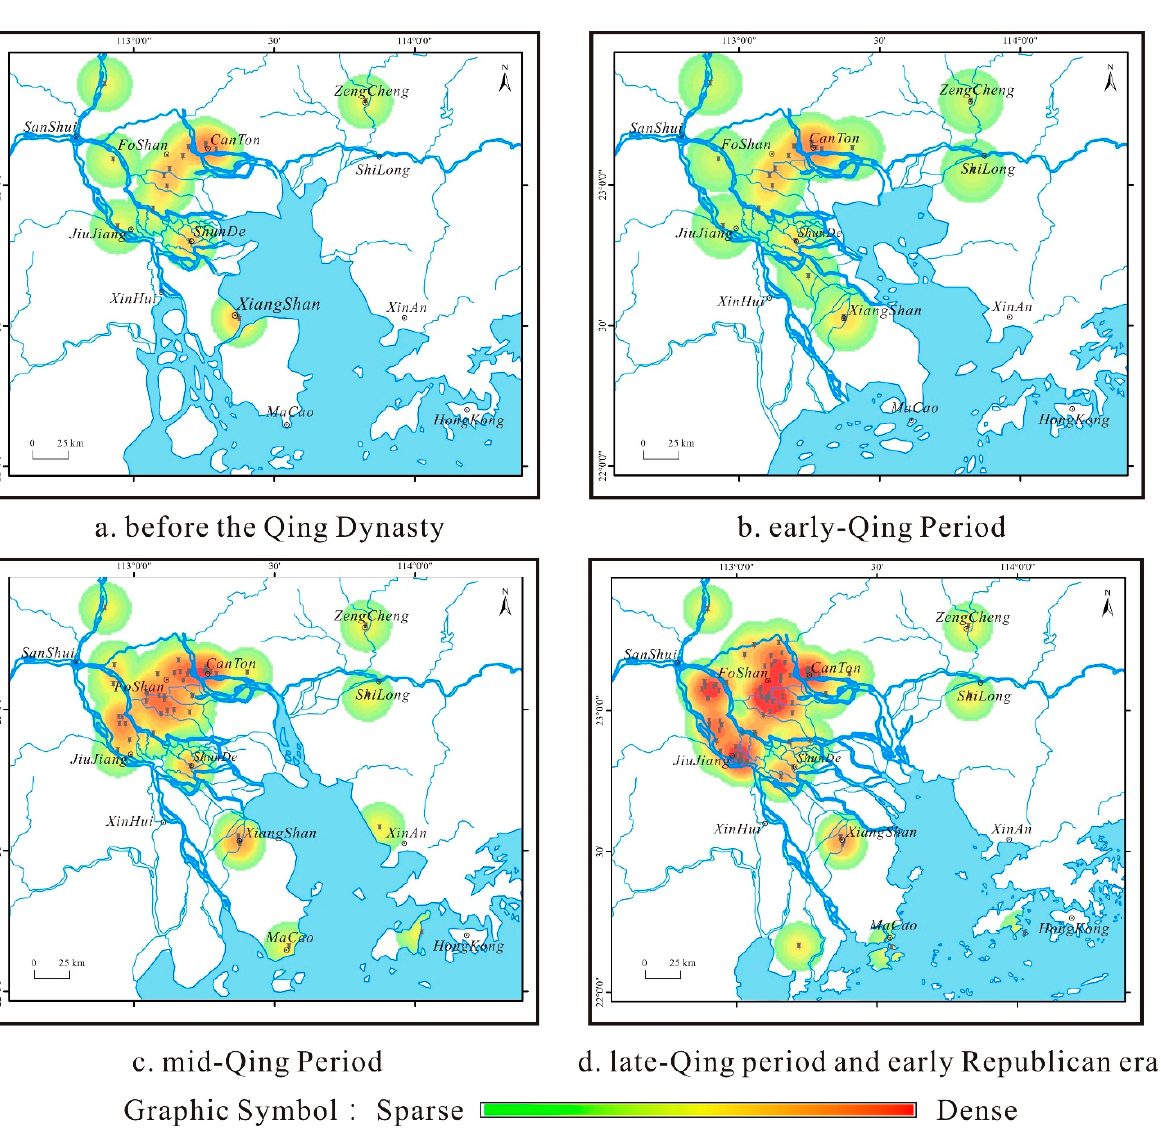
Figure 5. The process of the spatiotemporal evolution of Beidi